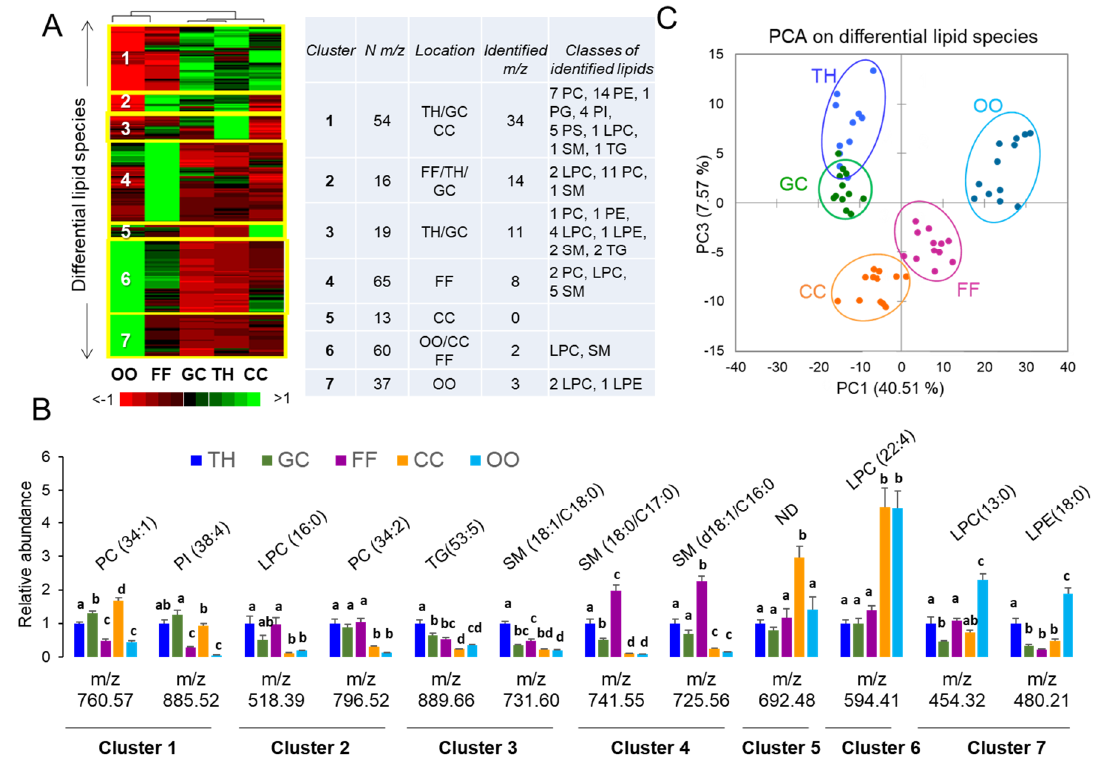
Figure 5. Differential analysis of lipids in bovine TH (theca), GC (granulosa cells), FF (follicular fluid), CC (cumulus cells), and oocytes (OO) by MALDI-TOF MS lipid profiling. ( A ) Heat map representation of differentially abundant lipids (ANOVA, p < 0.05). Enclosed table showed the number of peaks per cluster, their specific localization to the ovarian compartment, and the main lipid classes of the identified differential lipids. ( B ) Examples of identified differentially abundant lipids between ovarian compartments ( n = 12 per compartment). Different letters indicate significant differences ( p < 0.05, Tukey test for multiple pairs comparison). ( C ) Discrimination of ovarian follicular compartments by their lipid profiles, by principal component analysis. LPE—Lyso-